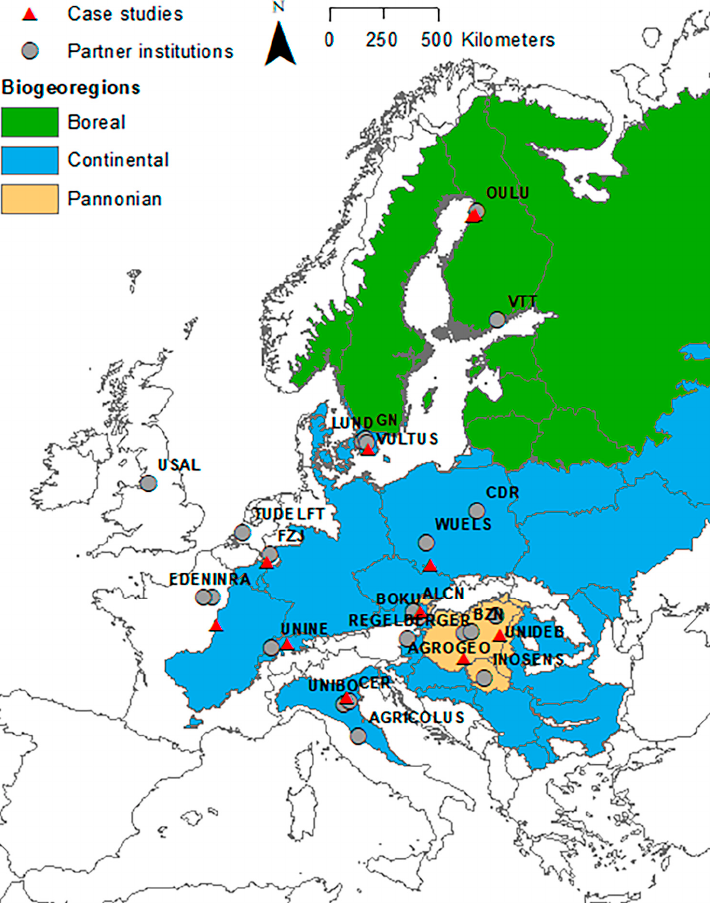
Figure 5. WATERAGRI case study demonstration sites and partner overview for all target regions (LUNDS UNIVERSITET, ULUND; EDEN TECH; EDEN; FORSCHUNGSZENTRUM